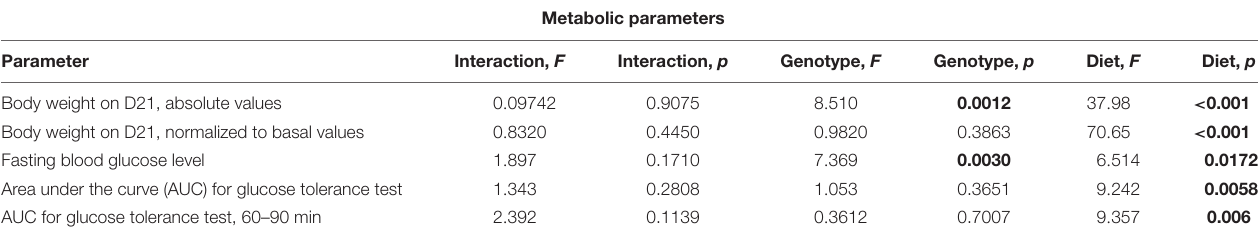
TABLE 1 | Two-way ANOVA results for statistical analysis of metabolic parameters.